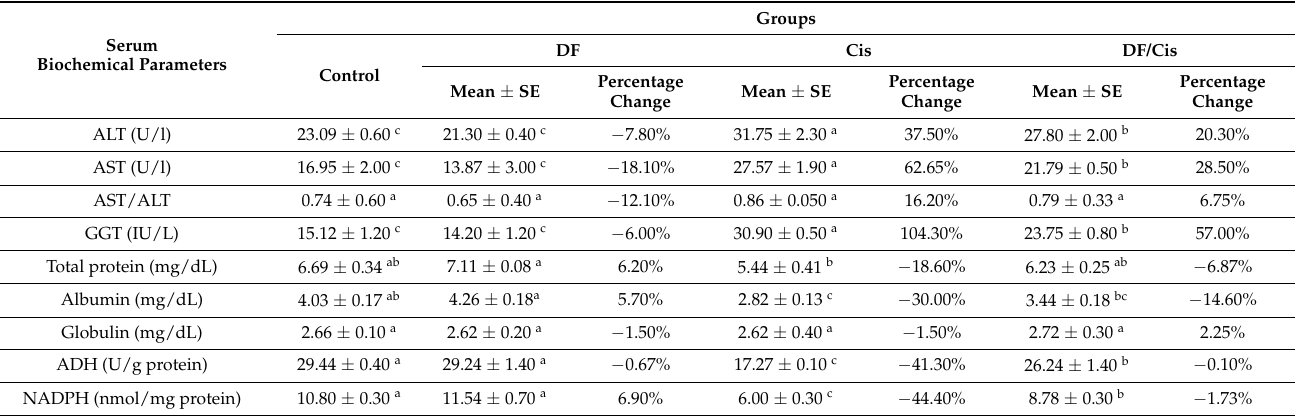
Table 2. Effects of pretreatment with methanolic date flesh extract (MDFE) on serum biochemical parameters, and hepatic ADH and NADPH in cisplatin-injected rats.